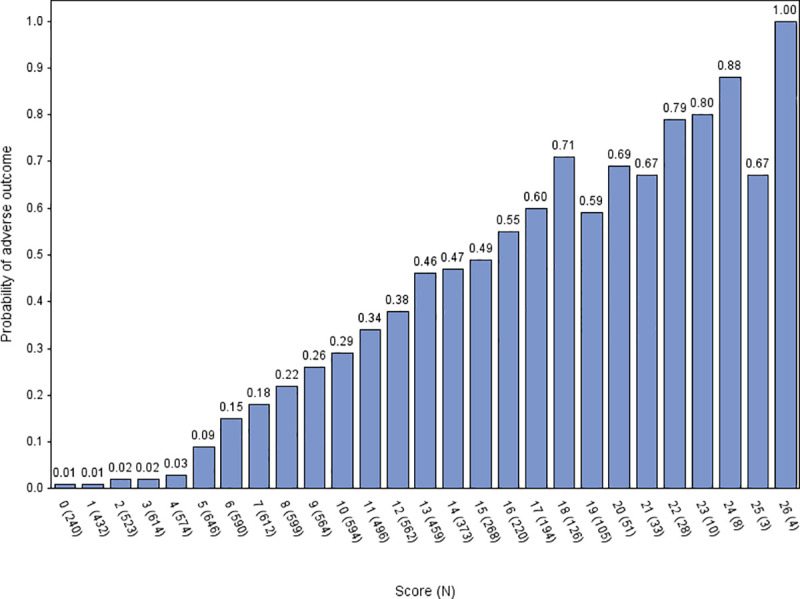
Probability of adverse outcome for each value of the score, validation cohort.